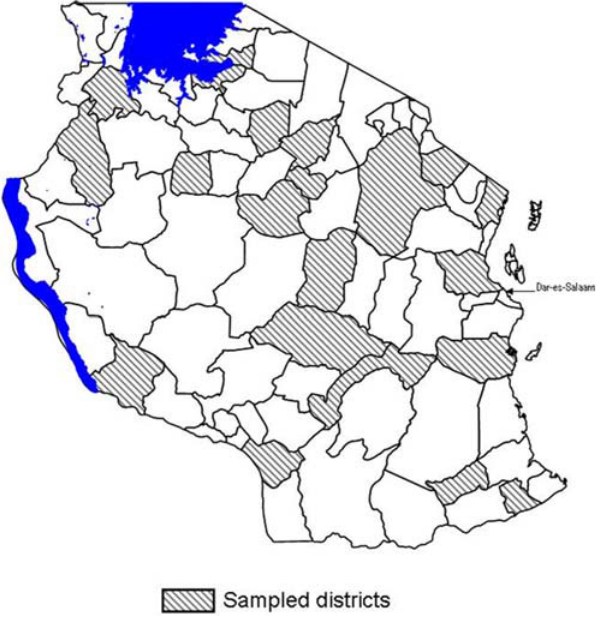
Figure 1. Districts where antimalarial drugs were collection in mainland Tanzania,